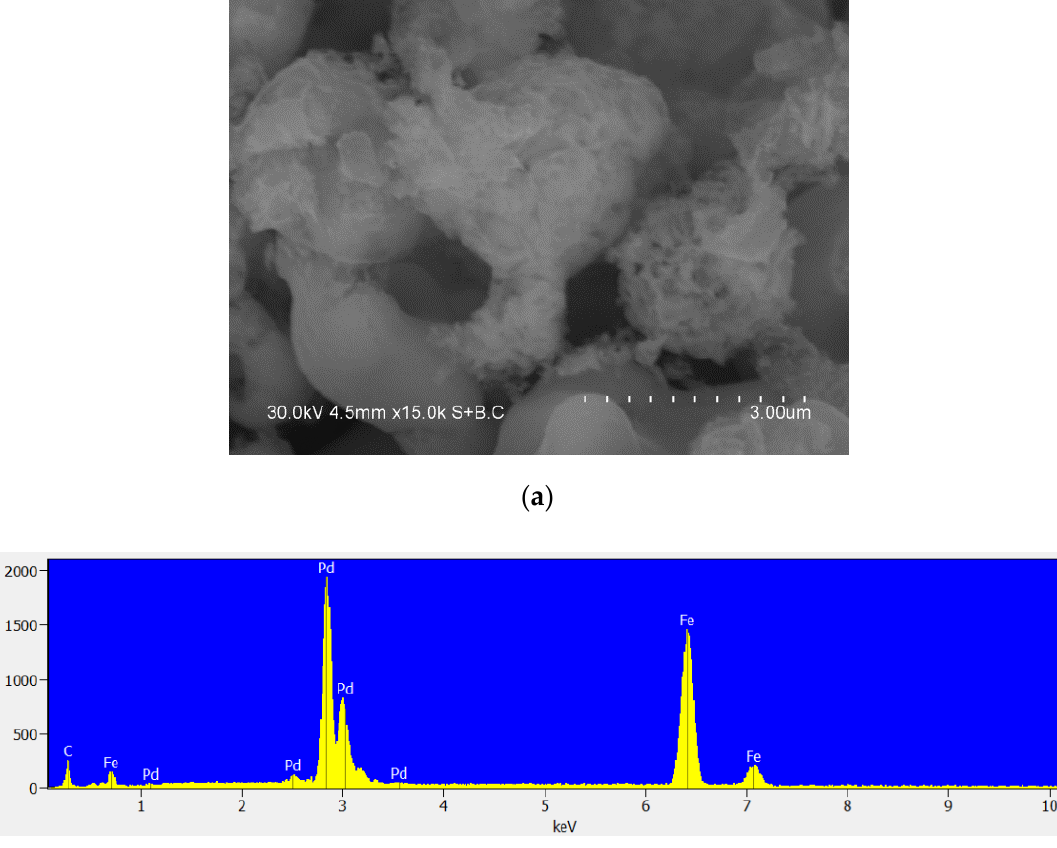
Figure 14. Morphology of the annealed powder treated in HCl solution ( a ), EDS of the annealed powder treated in HCl solution ( b ).